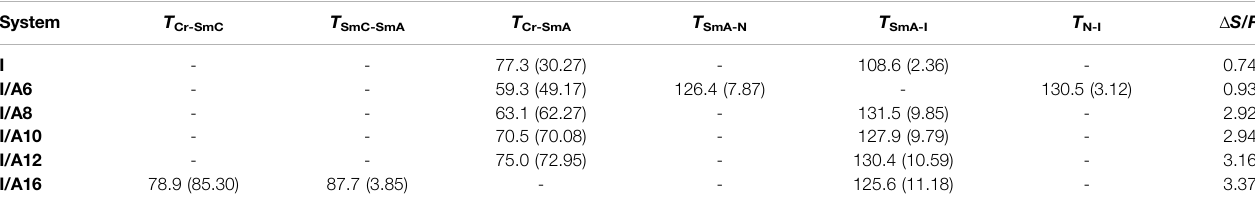
TABLE 1 | Mesomorphic transition temperatures ( ° C), enthalpy (kJ/mol), and normalized entropy of transitions for present SMHBCs I/An.